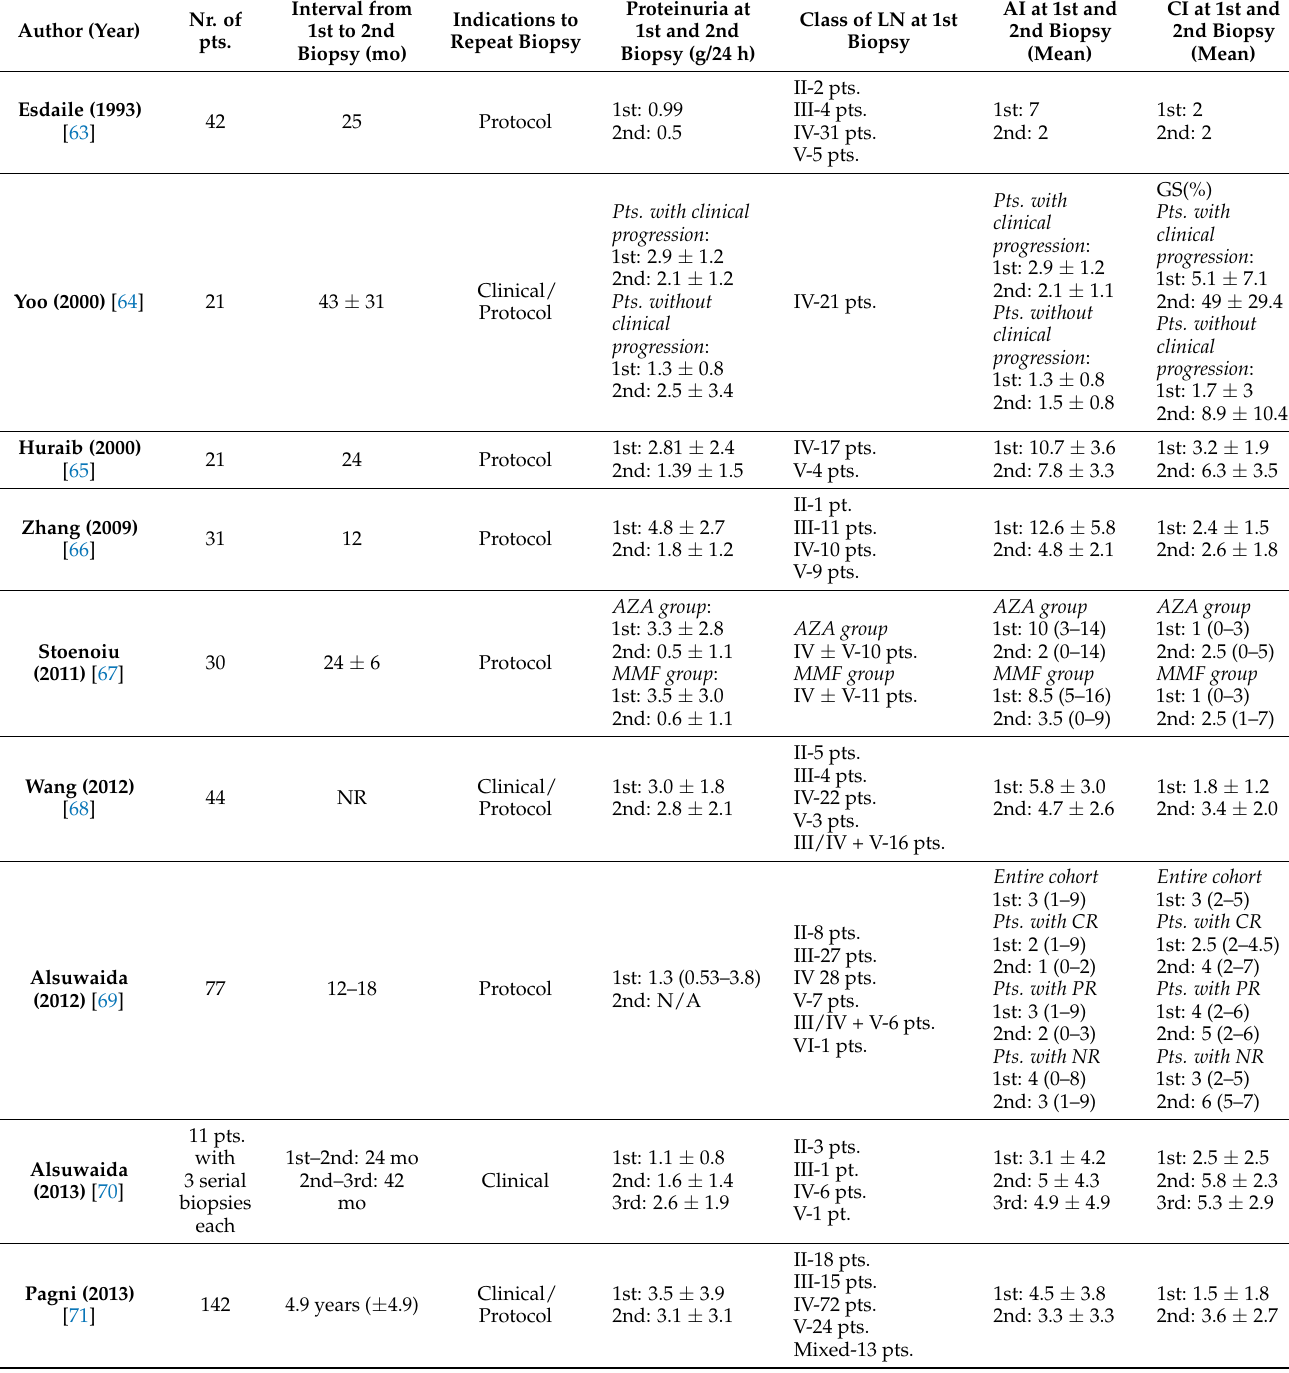
Table 5. Studies evaluating the role of repeat kidney biopsy in LN during maintenance